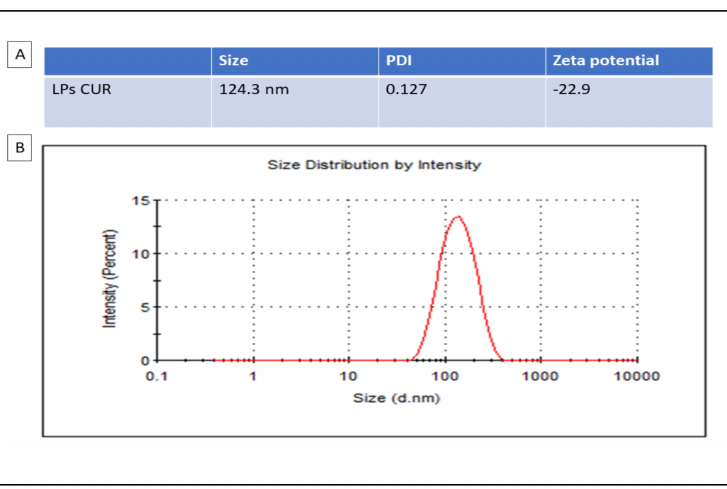
Figure 1. Particle sizes analysis with DLS (dynamic light scattering) are presented in the table ( A ) and the distribution by zeta potential of LPs-CUR is presented in the graph ( B ).